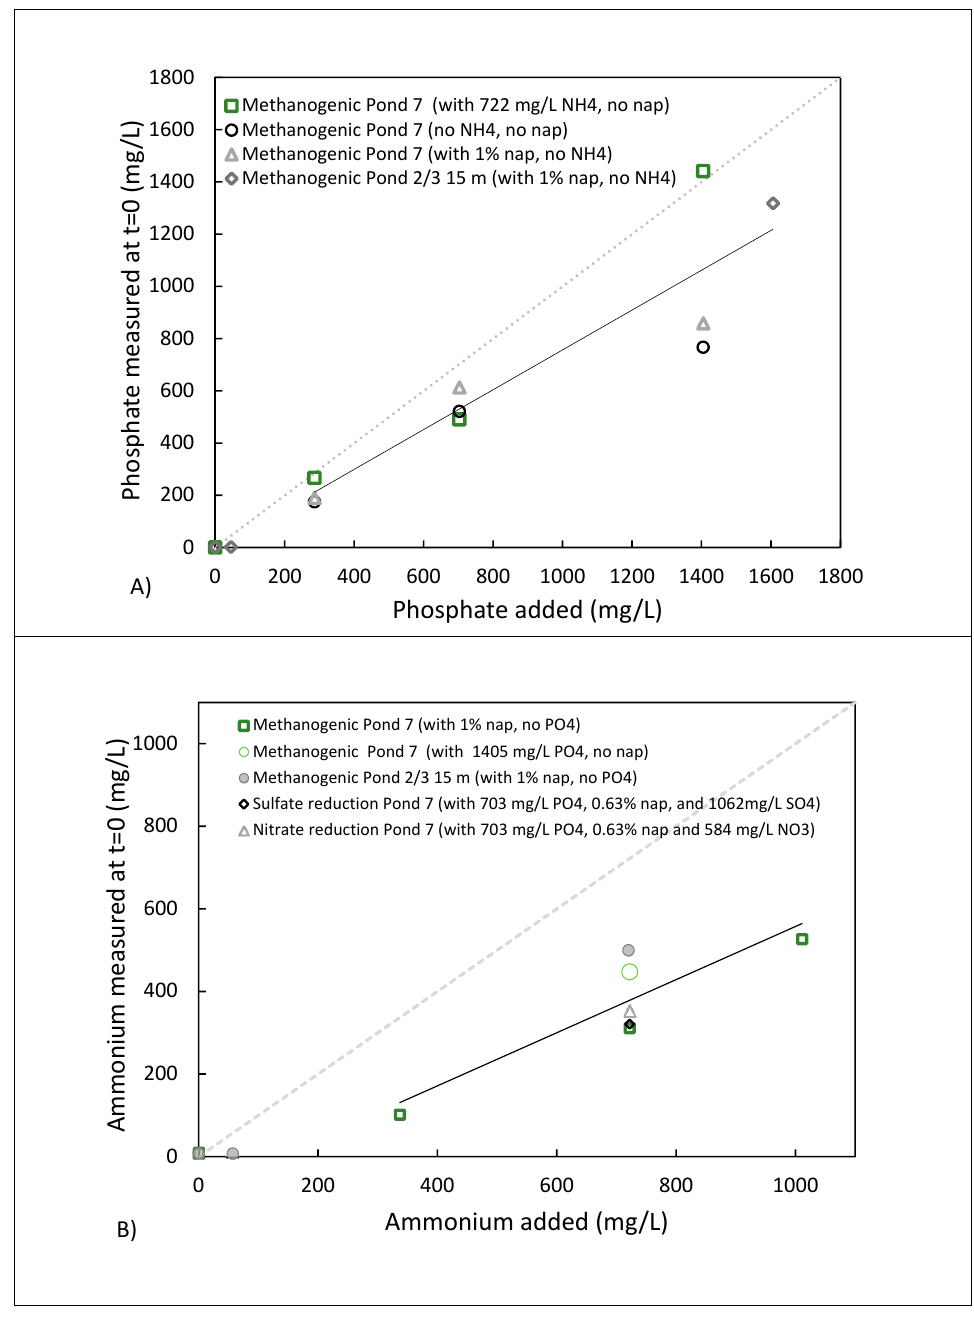
Figure 5. Plots showing the amount of ( A ) PO 4 3 − and ( B ) NH 4 + added to MFT samples and the “initial” concentration measured in the pore water. After phosphate and/or ammonium were added, the pore water was separated via centrifugation within a maximum of 6 h of experimental setup. The disappearance of phosphate and ammonium may be due to mineral precipita- tion or sorption onto the MFT matrix. To check for potential precipitates, after being mixed with ammonium and phosphate, the dried MFT solids were analyzed by X-ray diffraction. There was no evidence of precipitates such as struvite (NH ₄ MgPO ₄ ·6H ₂ O), so if any pre- cipitates were formed, they were below detectable levels.